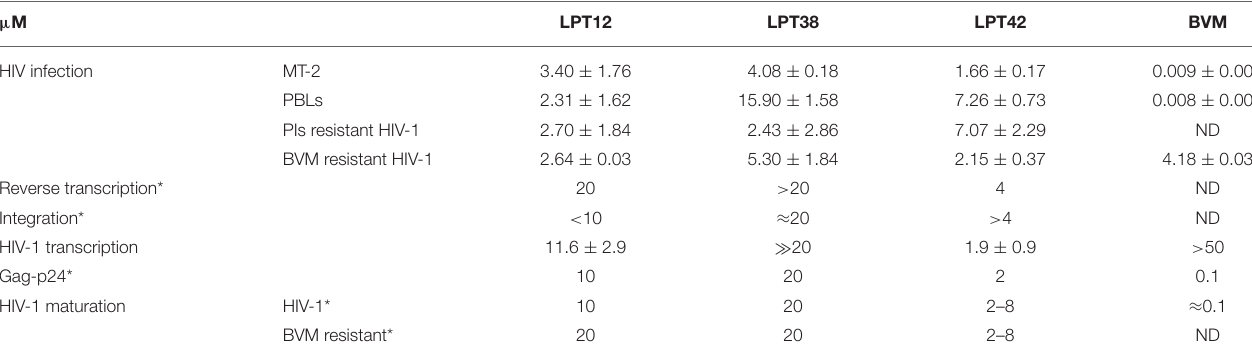
TABLE 1 | Summary of the IC 50 values ( µ M) and active concentrations obtained for LPT12, LPT38, LPT42, and Bevirimat in the different targets of the HIV-1 replication cycle studied. µ